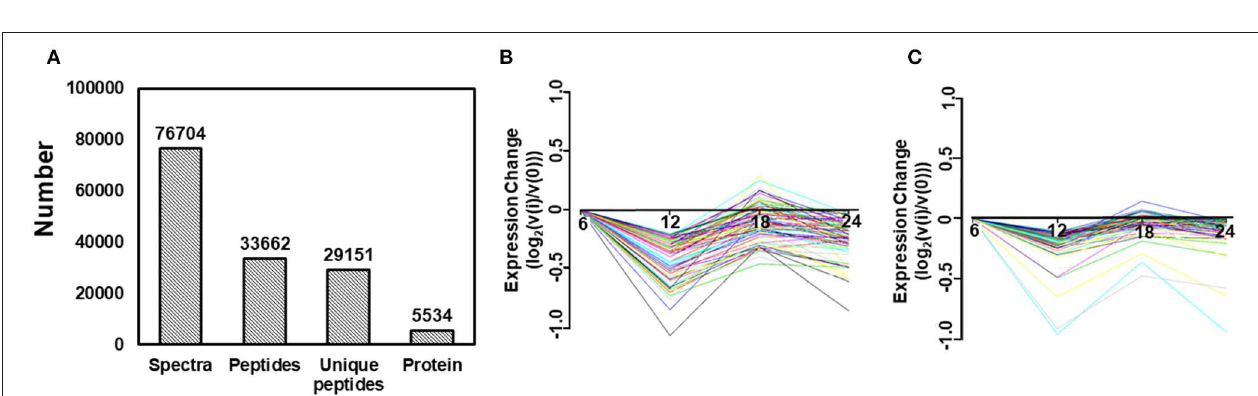
FIGURE 3 | Quantitative proteomic analysis of HeLa cells infected with C. muridarum TC0668 wt or TC0668 mut strains. (A) Basic statistics of proteome results from iTRAQ. Spectra, secondary mass spectra after quality control; Unique peptides, identified peptides that belong to only a group of proteins; and protein, identified proteins using Mascot 2.3.02 software. (B) Trends of differentially expressed proteins in TC0668 wt -infected cells at 6, 12, 18, and 24h p.i. (C) Trends of differentially expressed proteins in TC0668 mut -infected cells at 6, 12, 18, and 24h p.i.